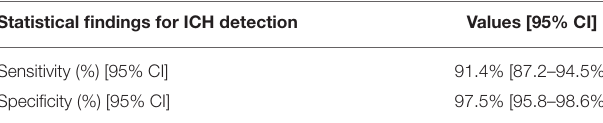
TABLE 1 | Performance metrics for overall cases of CINA-ICH